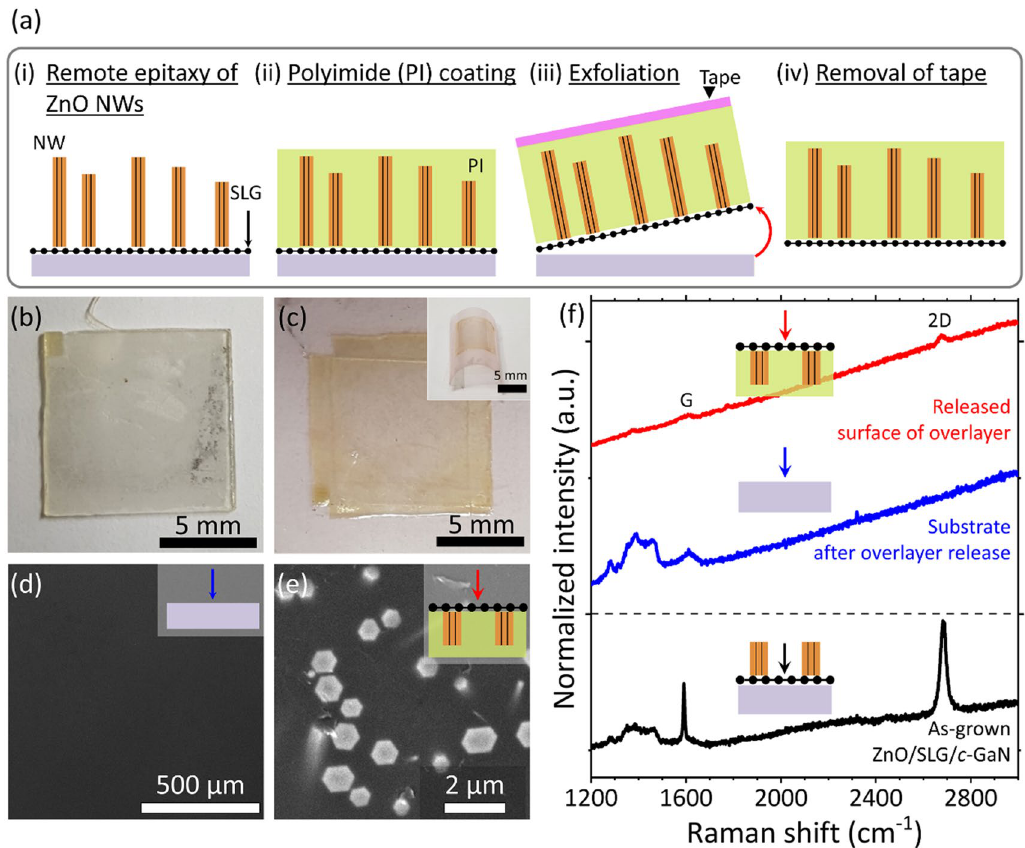
Figure 7. Exfoliation of remote epitaxial ZnO crystals using a sticky tape. ( a ) Illustration of procedures of exfoliation of ZnO crystals using thermal release tape. Photographs of ( b ) host substrate and ( c ) NWs-exfoliated thermal release tape after the exfoliation process. SEM images of ( d ) remained mother substrate and ( e ) bottom side of NWs-encapsulated PI film after the delamination. ( f ) Raman spectra of as-grown ZnO NWs/SLG/ c -GaN before exfoliation (black line), the donor substrate after release (blue line), and the NWs-encapsulated PI film (red line) after exfoliation. Color arrows of the schematics represent the observed specimen surface with the direction of electron beam and laser irradiation in the SEM and Raman spectroscopic analyses,